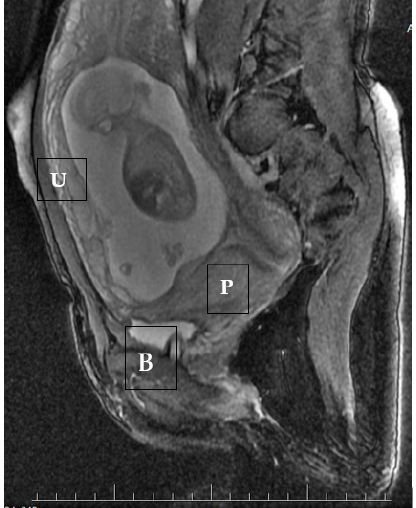
Figure 4. A magnetic resonance sagittal image of the cesarean scar pregnancy at 15 weeks, showing the infiltration of the trophoblast into the uterine wall and towards the bladder. U—uterus, P—placenta, B—bladder.